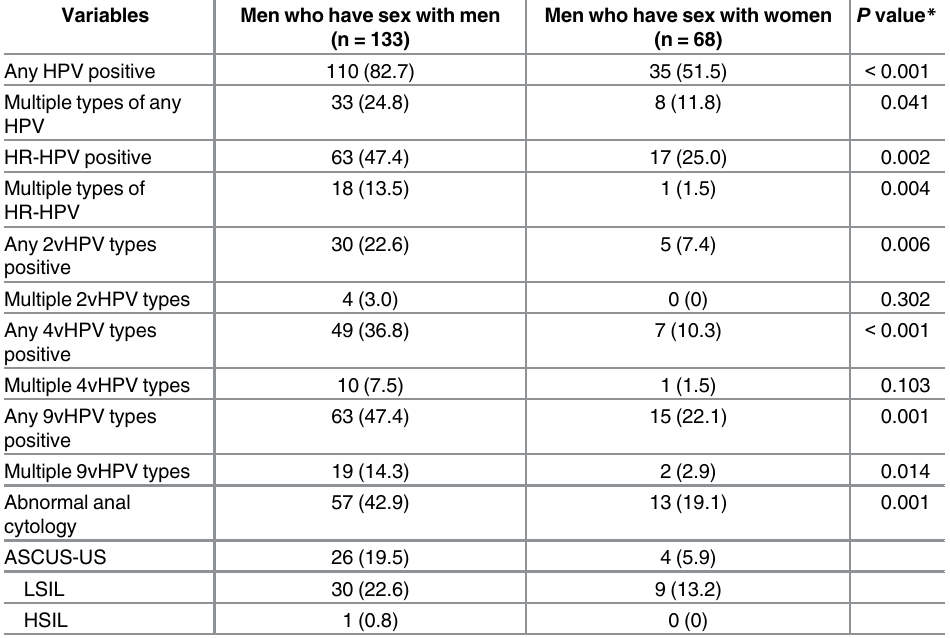
Table 2. Prevalence of Human papillomavirus (HPV) infection and abnormal anal cytology. Variables